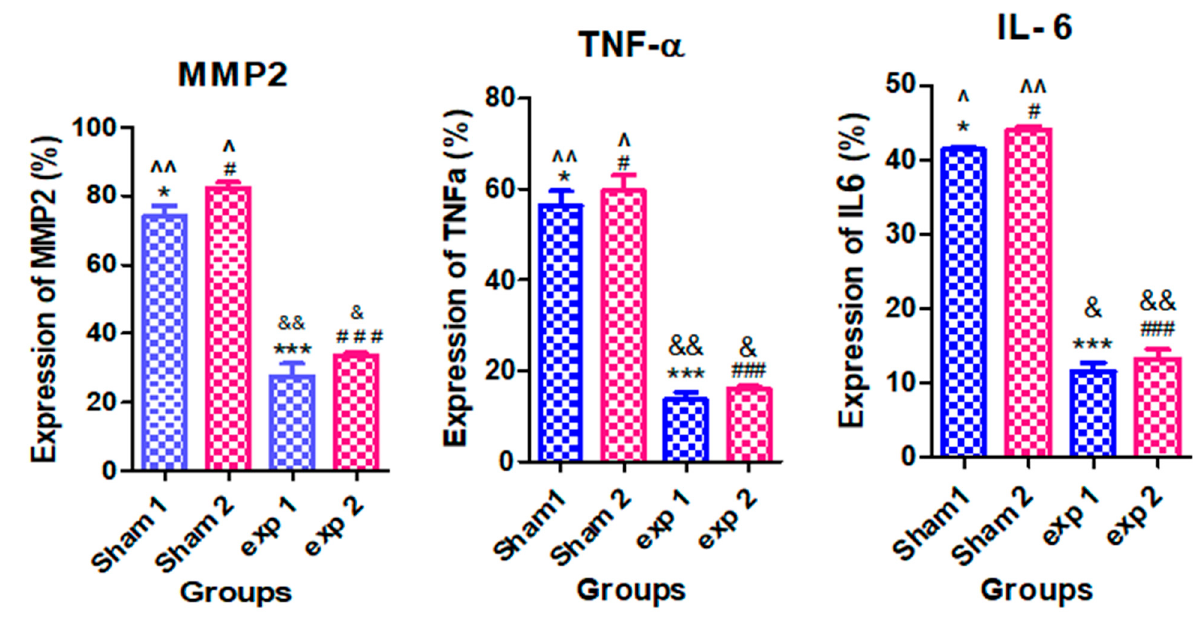
Figure 6. Comparison of expression of MMP2, TNF- α , and IL-6 proteins was induced in adipose tissue cells at the subcutaneous injection site. Results are presented as mean ± SE for 4 rats (n = 4). (* p < 0.05), (*** p < 0.001) show the difference from Sham1; (# p < 0.05), (### p < 0.001) show the difference from Sham2; (^ p < 0.05) and (^^ p < 0.01) show the difference from Sham2; (& p < 0.05) and (&& p < 0.01) show the difference from Exp2. (Exp1 and Exp2 are experimental groups #1 and 2 respectively).